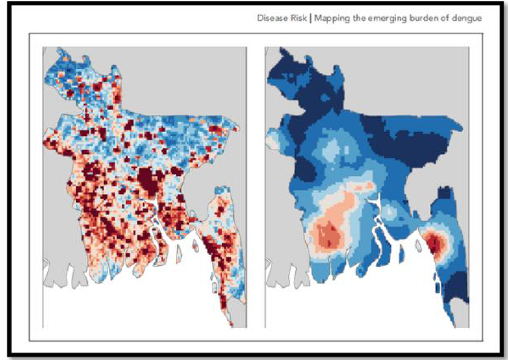
Figure 2 . Mapping of Dengue (Salje et al., 2019)